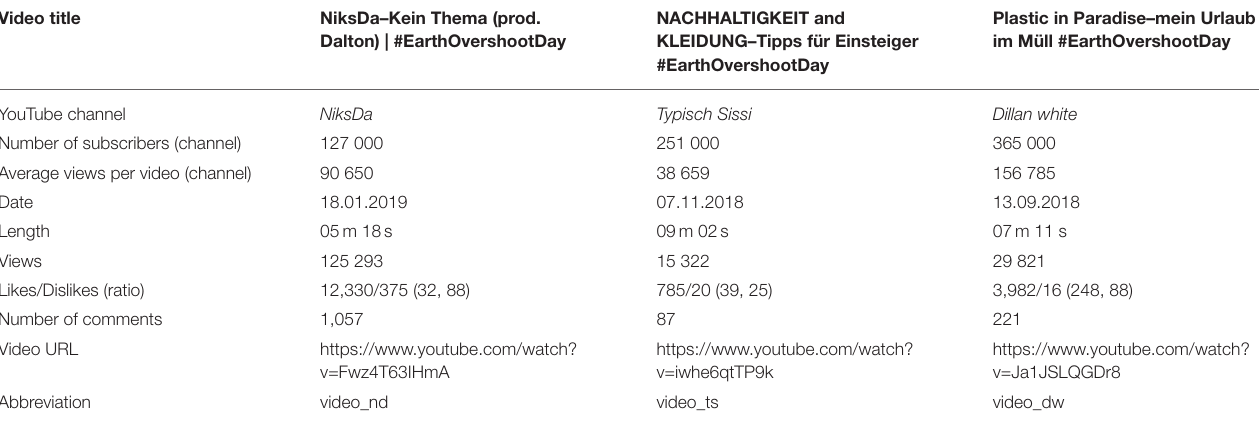
TABLE 1 | Overview on the three videos analyzed in the case